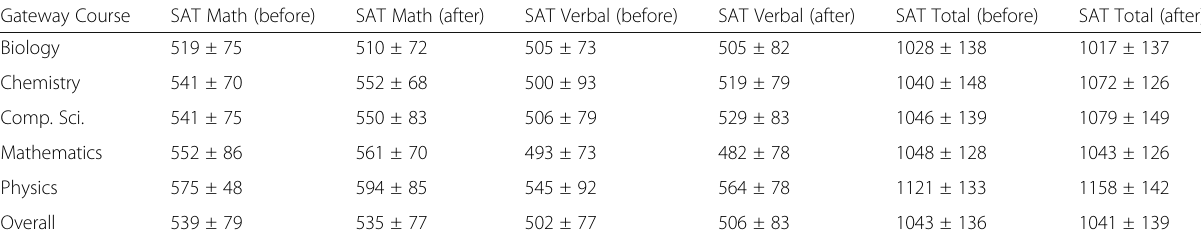
Table 3 The average incoming SAT scores of majors in the gateway course listed, with the standard deviation of the sample indicated. Overall, no meaningful change is present in the SAT scores of incoming students in the gateway courses